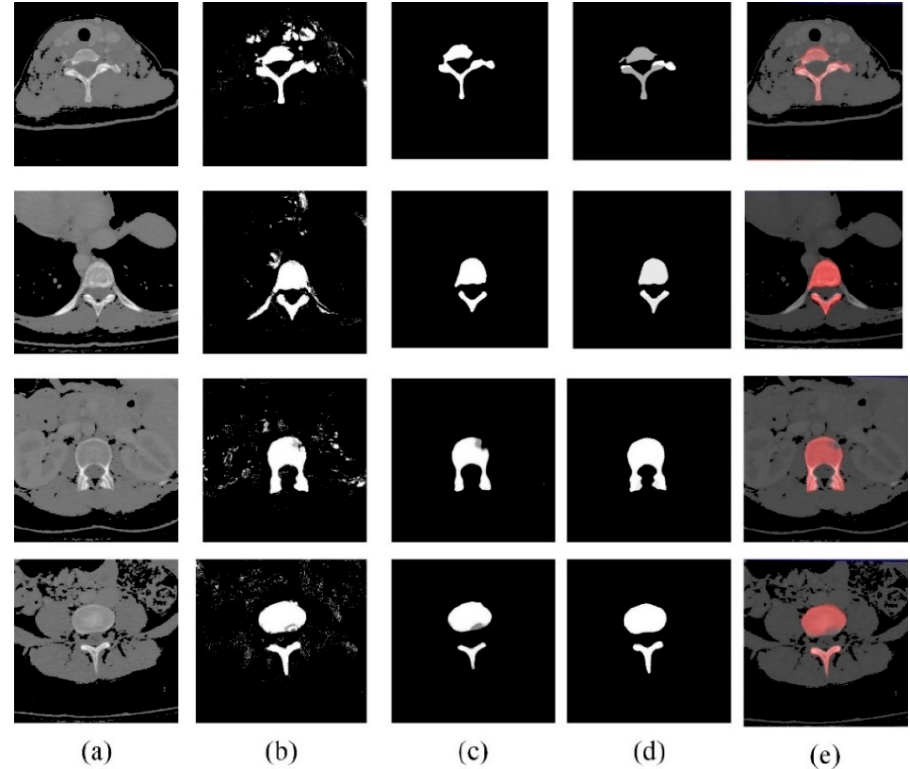
Figure 8. Segmentation results from randomly selected axial slices of test CT image 1: ( a ) raw image; ( b ) initial segmentation; ( c ) finial segmentation; ( d ) ground truth; and ( e ) segmentation superimposed on CT image.